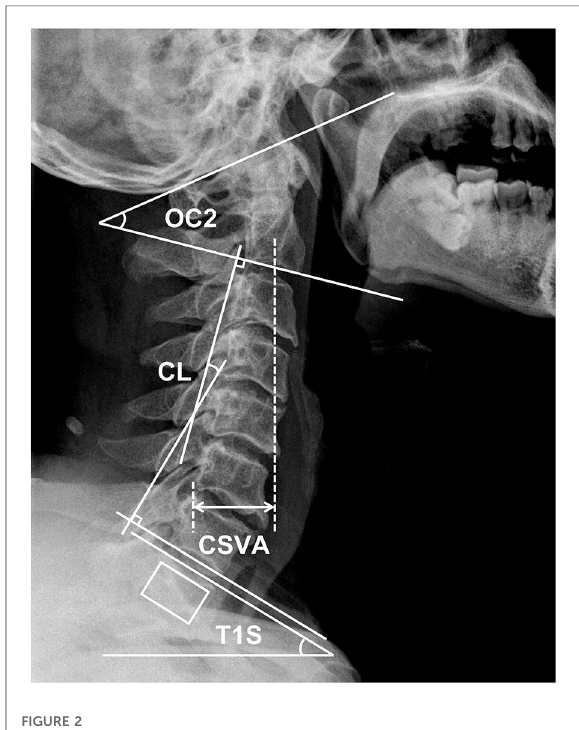
FIGURE 2 Measurements of cervical sagittal parameters utilized in this study.